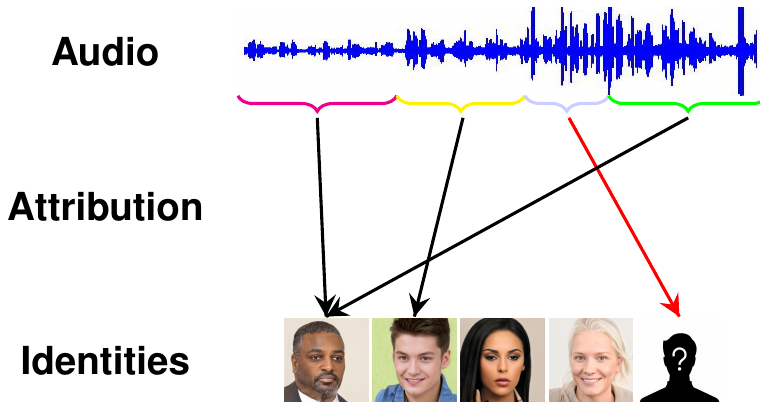
Figure 1. Concept diagram of speaker attribution. For the given audio, we assign the portion of speech generated by each enrolled speaker. Additionally, we must also detect the audio belonging to non-enrolled speakers (red arrow).